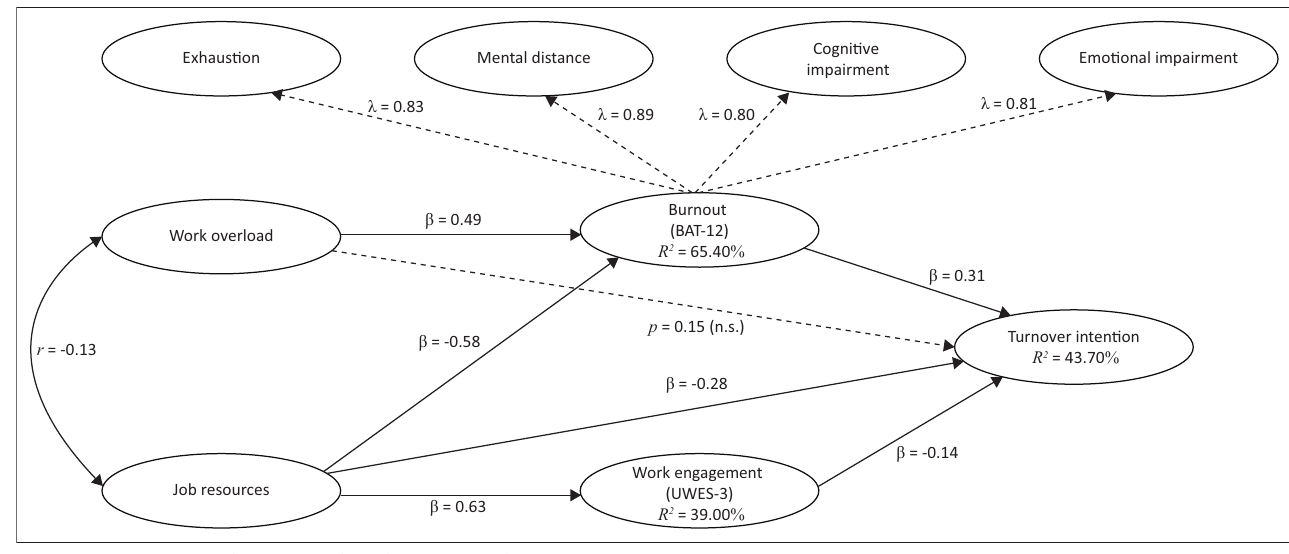
FIGURE 1: The Job Demands-Resources model for the research study.